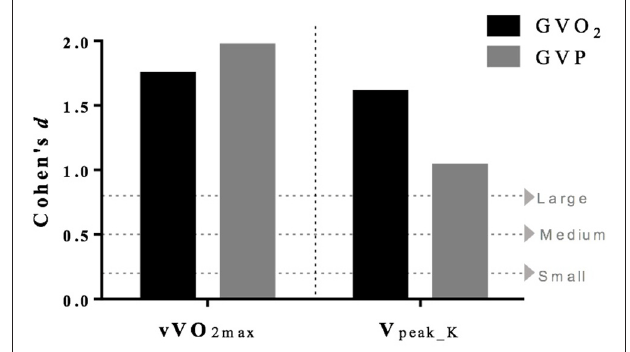
FIGURE 1 | Cohen’s effect size comparing post- vs. pre-training period for vVO2max and